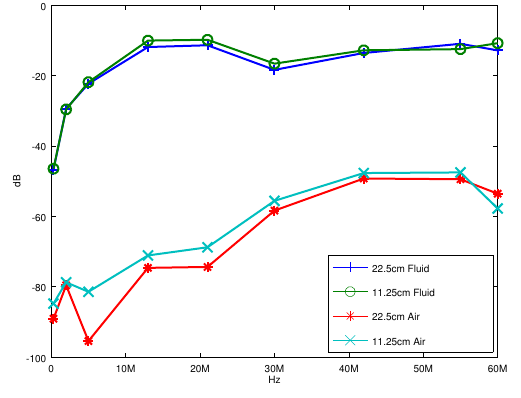
Figure 9: Spectrum plot of received signal (blue) and reference signal (green) at 30MHz through the phantom solution with d = 22 . 5 cm .